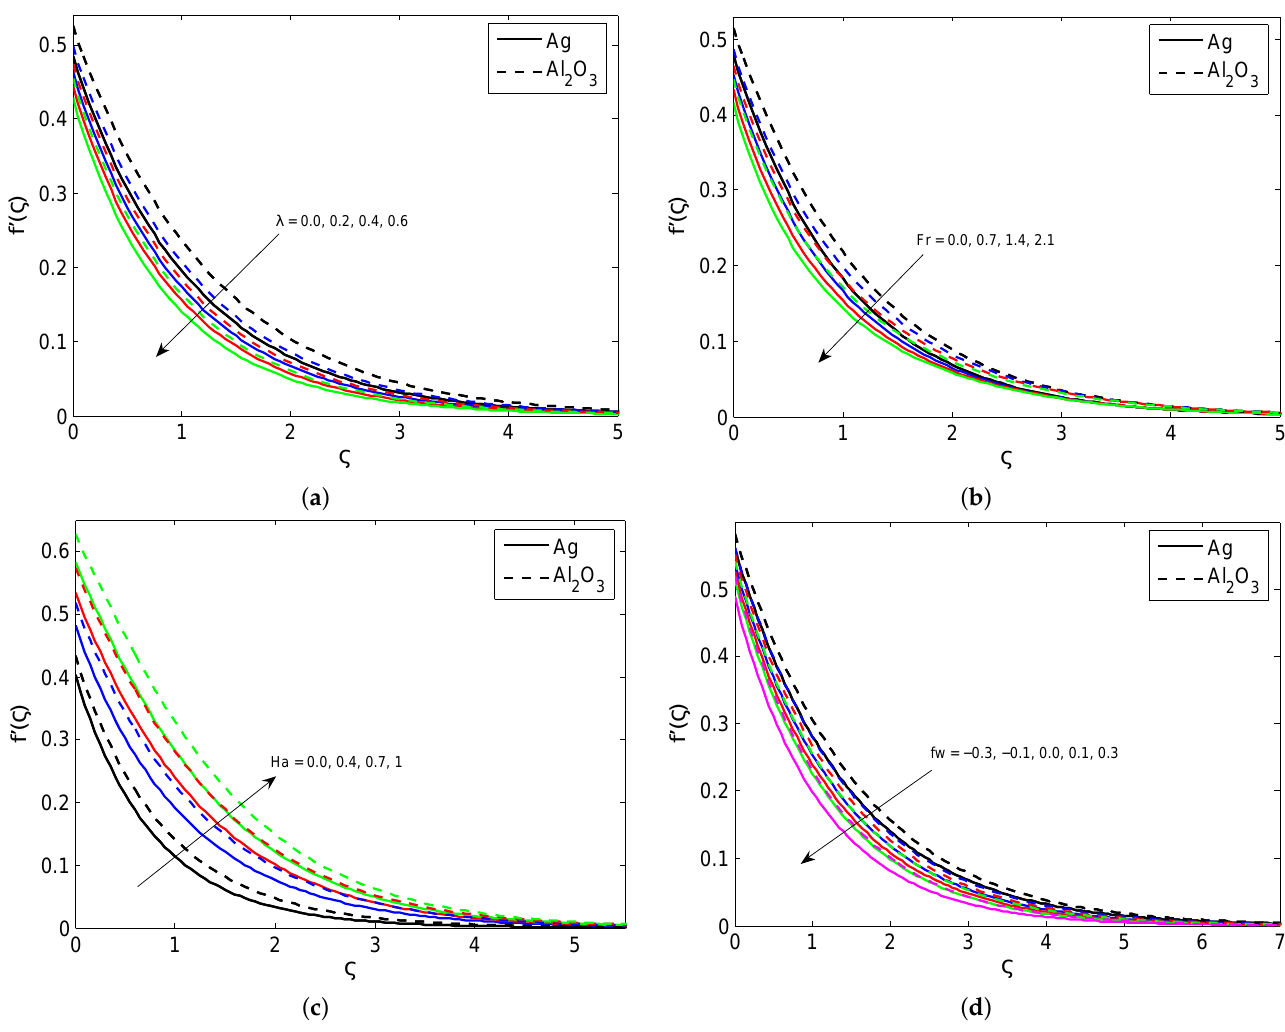
Figure 2. The variation of f (cid:48) ( ς ) in relation to ( a ) λ , ( b ) Fr , ( c ) Ha and ( d ) fw